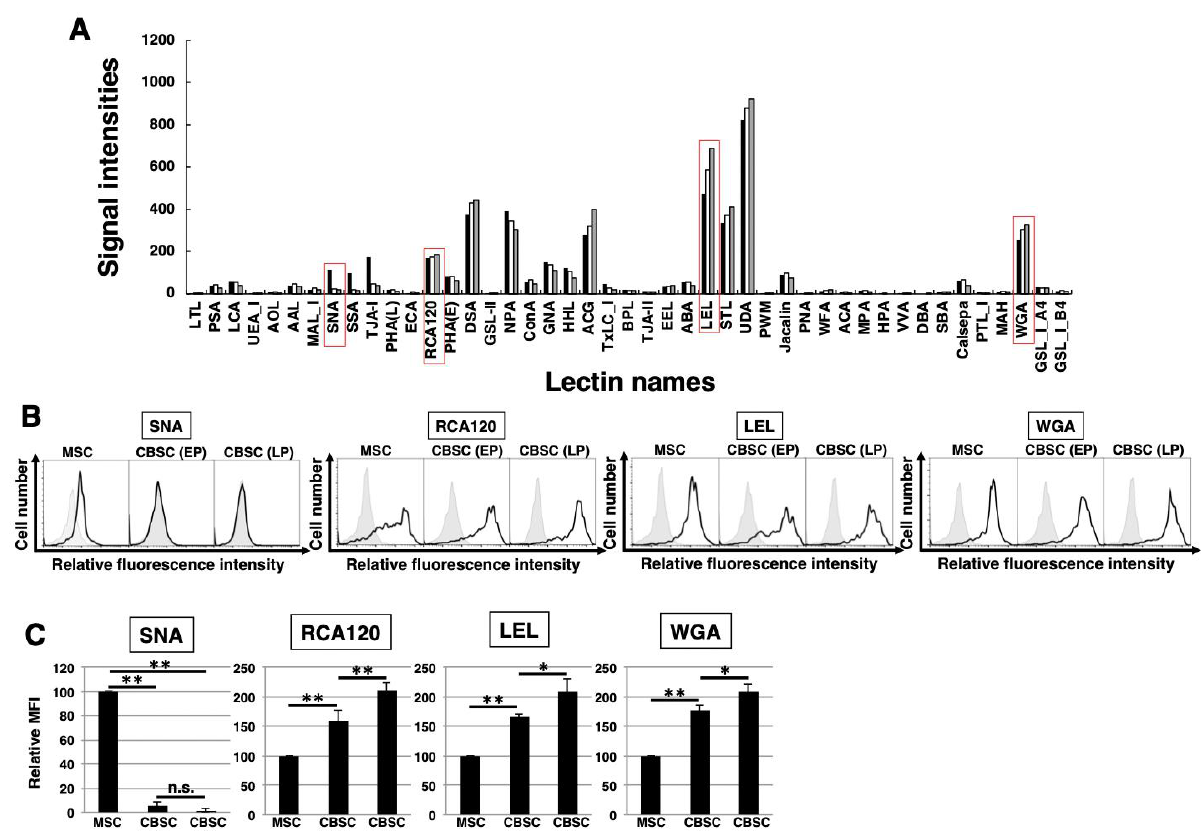
Figure 3. The feature of glycan profiles of mCBSCs and mMSCs. ( A ) Glycan profiles of the mMSCs, mouse cortical-bone-derived stem cells at early passage (EP-mCBSCs) and those at late passage (LP-mCBSCs) by averaged data ( n = 10). Bar graph representation of signal intensities of 45 lectins in lectin microarray data. Closed, open, and gray bars show mMSCs, EP-mCBSCs, and LP-mCBSCs, respectively. The lectins enclosed in a red line are further experimented in ( B ) and ( C ). ( B ) FACS analysis of mMSCs, EP-mCBSCs, and LP-mCBSCs using lectins (SNA, RCA120, LEL, and WGA). Three independent experiments were performed and representative results are shown. Negative control is shown in gray. ( C ) MFIs relative to those of mMSCs (value = 100) are shown. Results are presented as means ± SD from three independent experiments. * p < 0.05, ** p < 0.01. Abbreviations: mMSC, mouse mesenchymal stem cell; mCBSC, mouse cortical-bone-derived stem cell; EP, early passage; LP, late passage; SNA, Sambucus nigra; RCA120, Ricinus communis agglutinin I; LEL, Lycopersicon esculentum; WGA, wheat germ agglutinin; MFIs, mean fluorescence